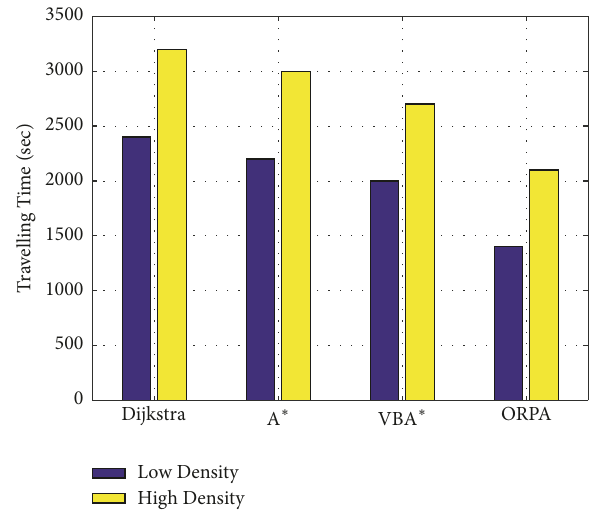
Figure 5: Travelling time in low- and high-density.